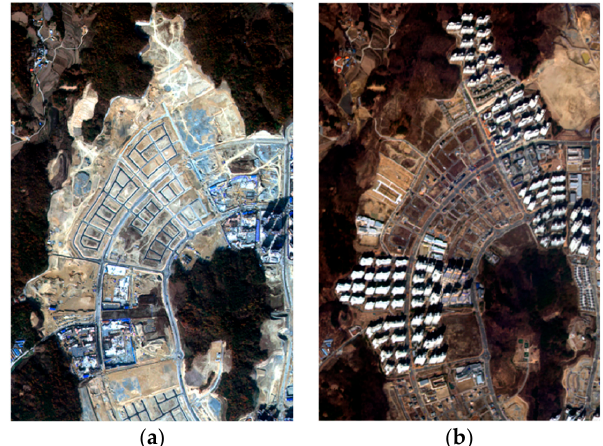
Figure 5. The second subset from KOMPSAT-3 images acquired over Sejong City, South Korea, in ( a ) 16 November 2013, and ( b ) 26 February 2019.